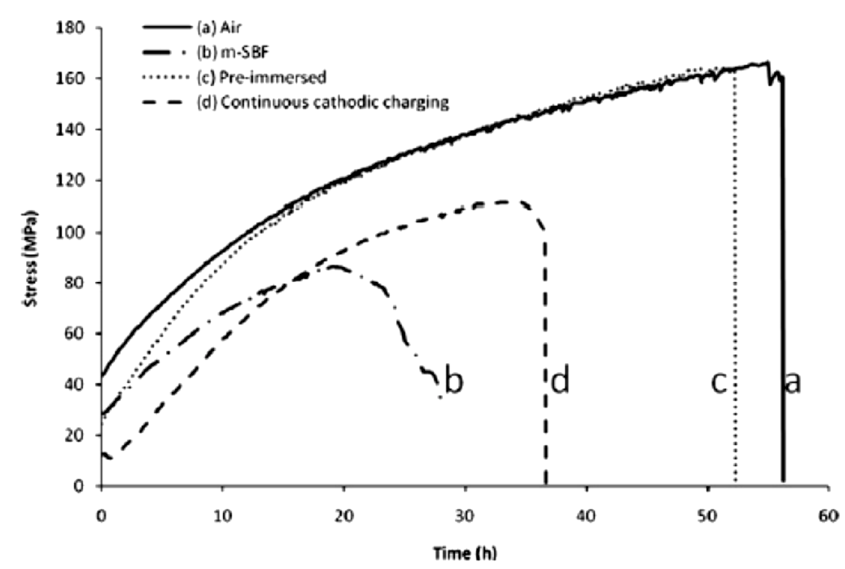
Figure 3. Stress-time plot of AZ91D alloy tested ate strain rate of 2.2 × 10 − 7 s − 1 under different environmental conditions. Reproduced with permission from [83], Elsevier, 2012.